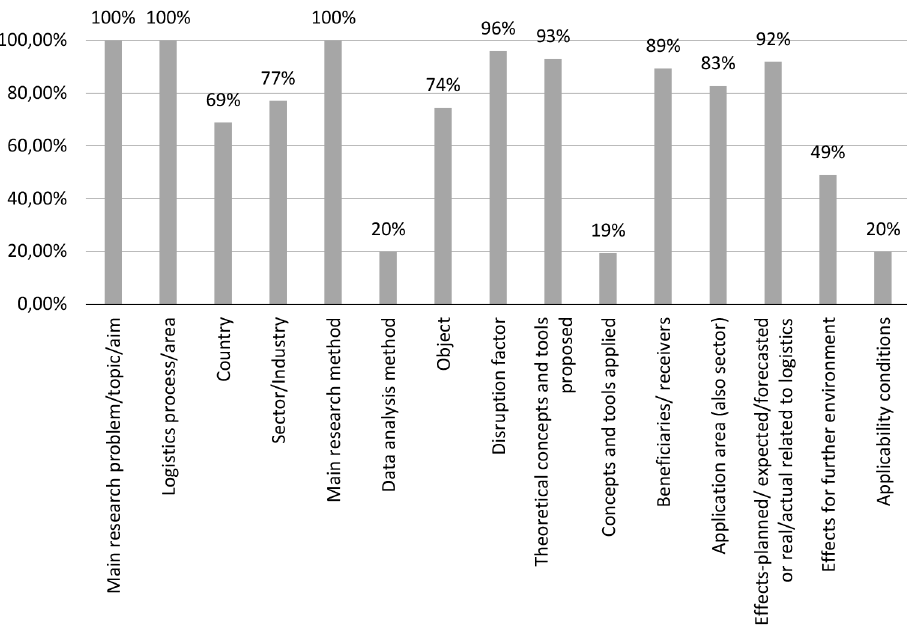
Figure 2. Share of 15 criteria identified in the analyzed literature